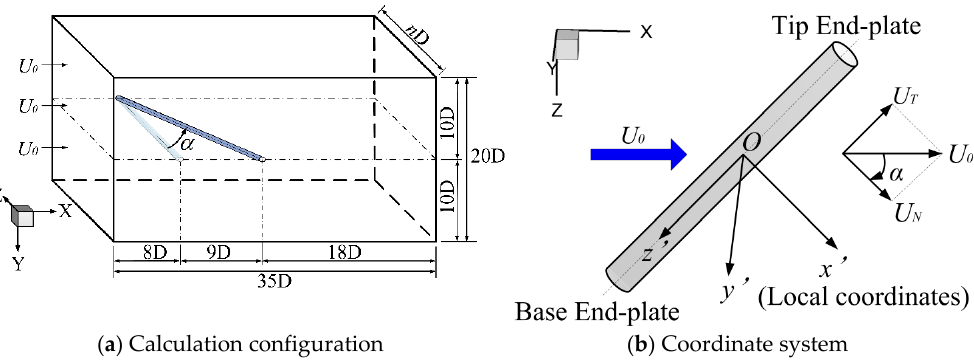
Figure 1. Definition of calculation configuration and coordinate system.